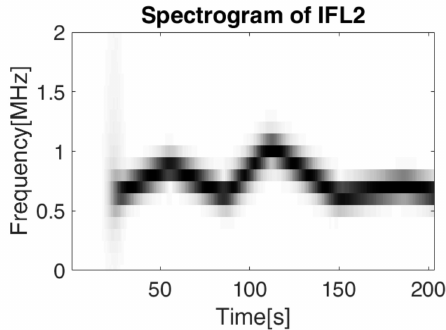
Figure 19. The estimation of the overlapped IF laws using the spectrogram: IFL 2 is estimated by subtracting IFL 1 (for a window of 128 samples, 120 overlapping samples and 128 points for the Fourier transform